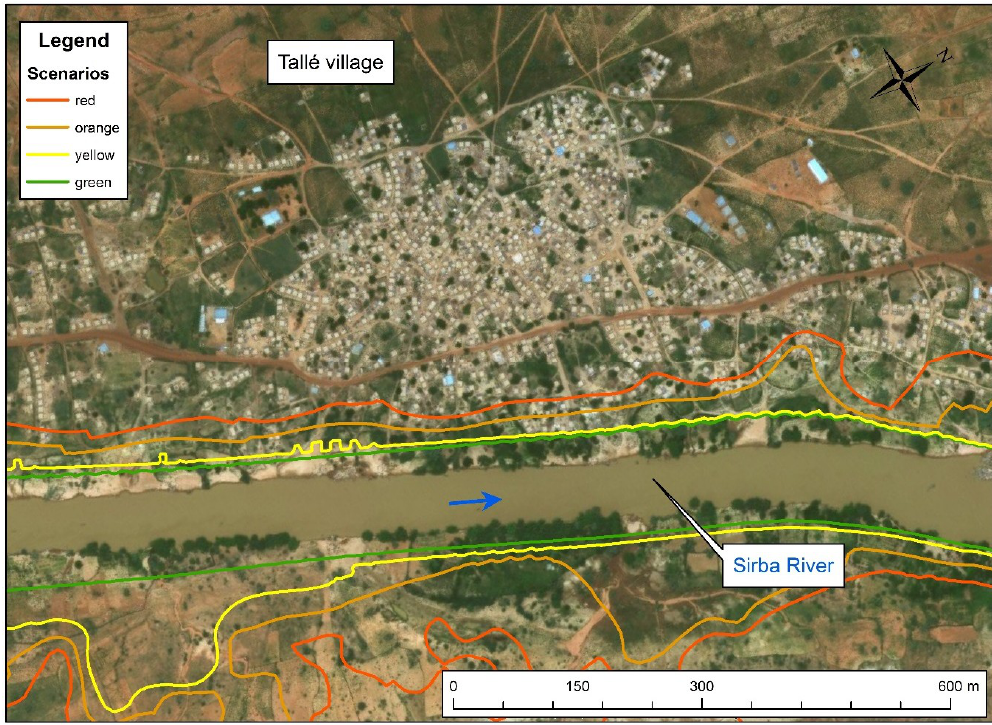
Figure 12. Flood hazard map in the village of Tallé: green: normal condition, yellow: annual flood, orange: severe flood and red: catastrophic flood. Base map aerial view (source ArcGIS world imagery [70]: 10 July 2016).